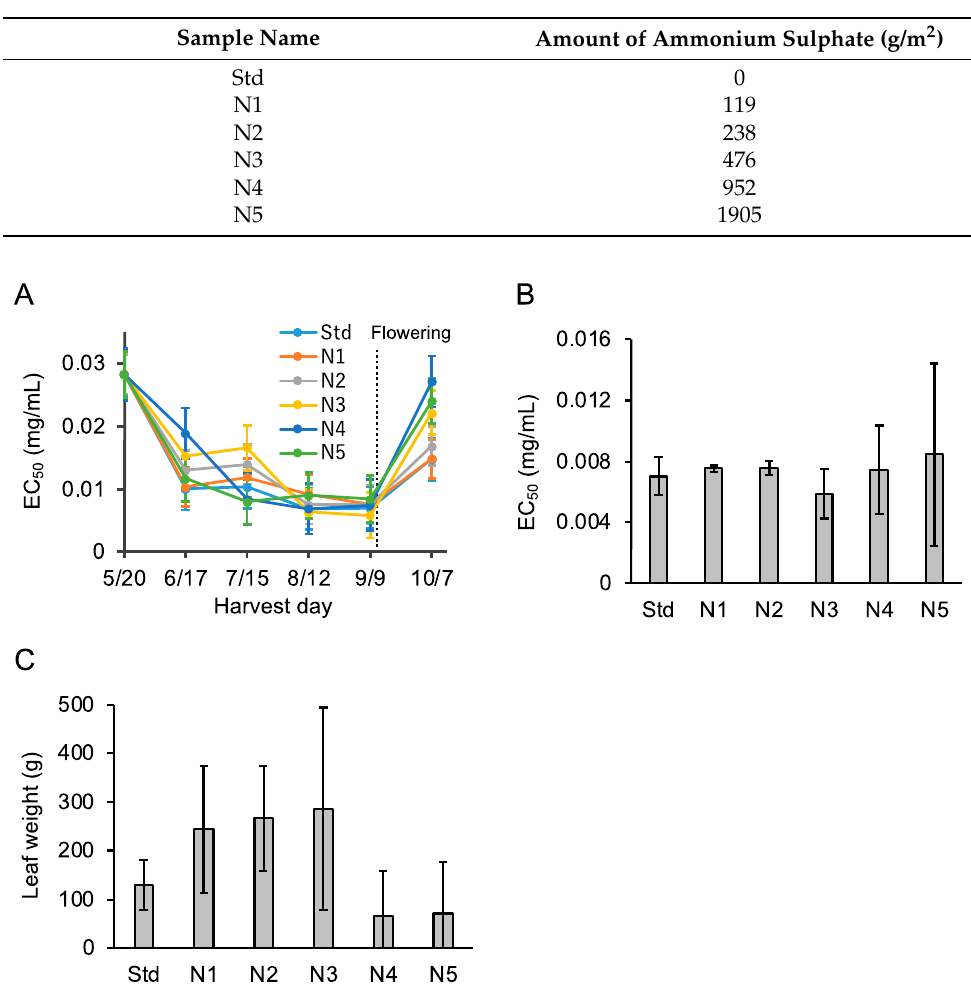
Figure 7. Nitrogen fertilization enhanced A β aggregation inhibitory activity and leaf weight. ( A ) A β aggregation inhibitory activity in leaves of Perilla frutescens var. crispa cultivated in a plastic green- house with six levels of ammonium sulfate fertilization (Table 2) and harvested every four weeks in 2020. ( B , C ) Activity ( B ) and leaf weight ( C ) just before flowering on September 9 in ( A ). Data represent as mean ± SD ( n = 3, separate plants).